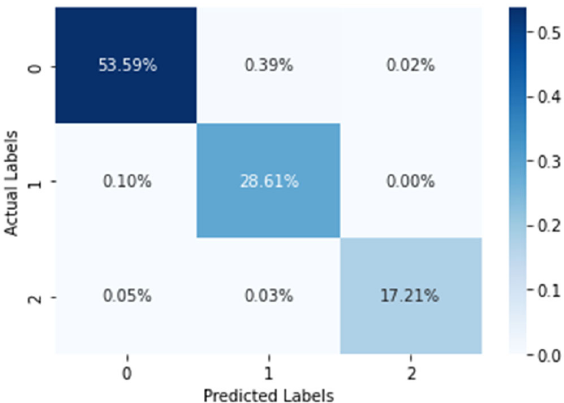
Figure 9. Confusion matrix generated by the proposed image-encoding-based deep neural network for the SWELL dataset where the percentage of data are being represented in each quadrant. Table 3. Performance of our proposed model for class-wise accuracy of SWELL dataset with different stress levels.